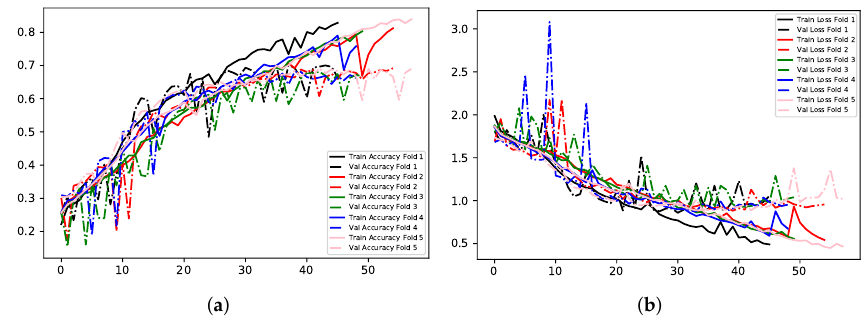
Figure 9. Model A experiment 1 results. ( a ) Accuracy. ( b ) Loss.